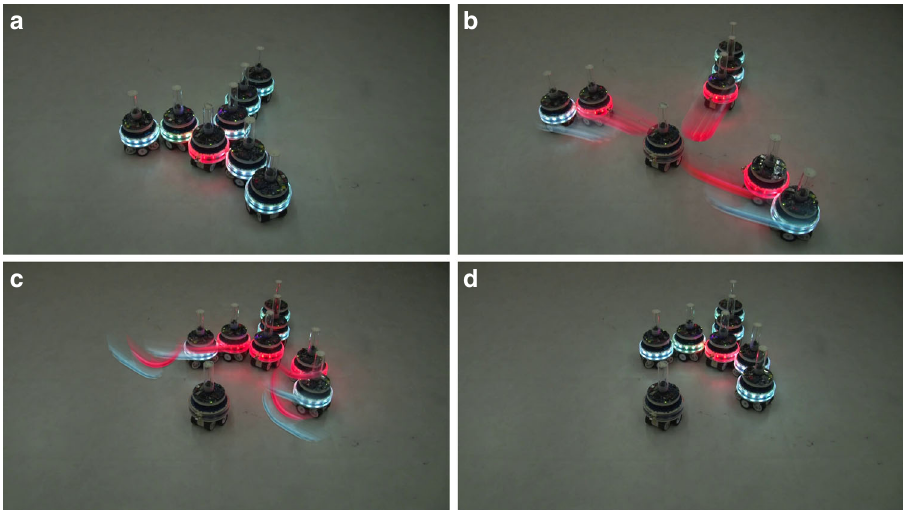
Fig. 5 An MNS robot self-heals after its brain unit develops a fault. Photos are snapshots from an experiment (Supplementary Movie 4). a A fault is injected in the brain unit. Using a heartbeat protocol (see Methods section), the three robotic units attached to the brain unit detect the fault. b All robotic units attached to the faulty brain unit detach. Each of these units now becomes the brain unit of a new MNS robot. c , d The three new MNS robots merge